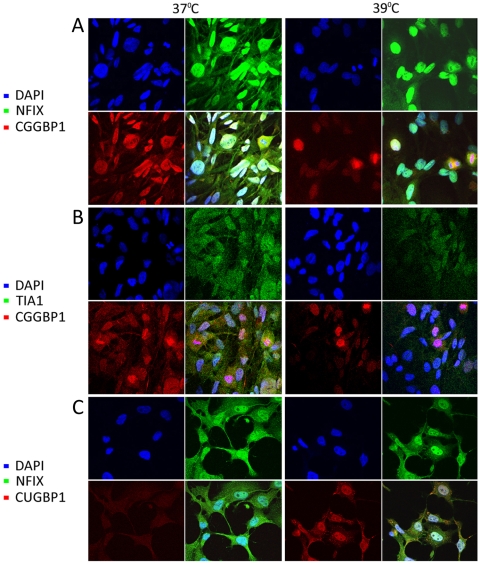
Immunofluorescence localization of NFIX and CGGBP1 in U-2987 MG cells after heat shock.Extranuclear presence of CGGBP1 and NFIX is reduced after heat shock (A). CGGBP1 co-localizes with TIA1 at 37°C but no preferential presence of CGGBP1 in stress granules is seen after heat shock (B). NFIX co-localizes with CUGBP1 after heat shock in both nuclei and cytoplasmic stress granules (C).